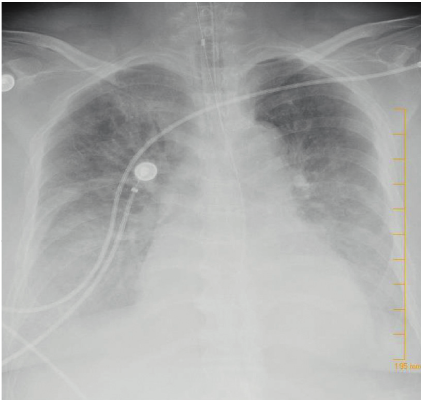
Figure 2: Bilateral interstitial and intra-alveolar infiltrates with small bilateral pleural